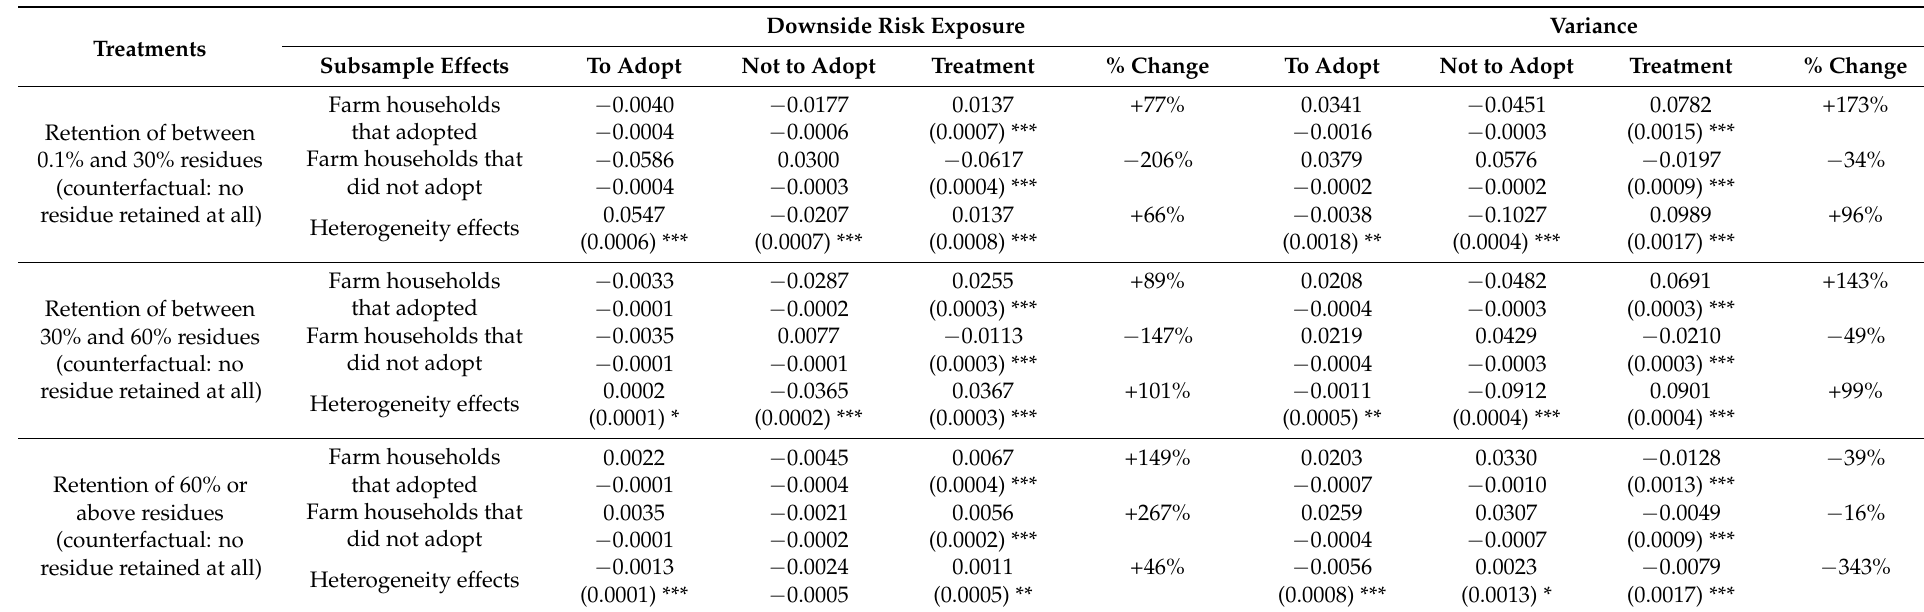
Table 6. Average expected treatment and heterogeneity effects on average expected downside risk exposure and variance of yield—ESR results.